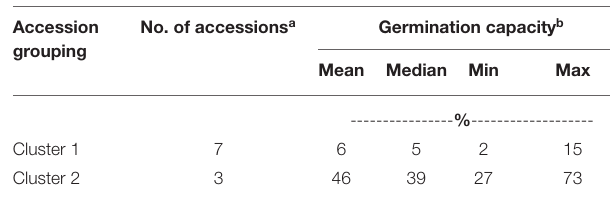
TABLE 7 | Germination capacity of Echinochloa muricata from Arkansas, USA, averaged across accessions in a